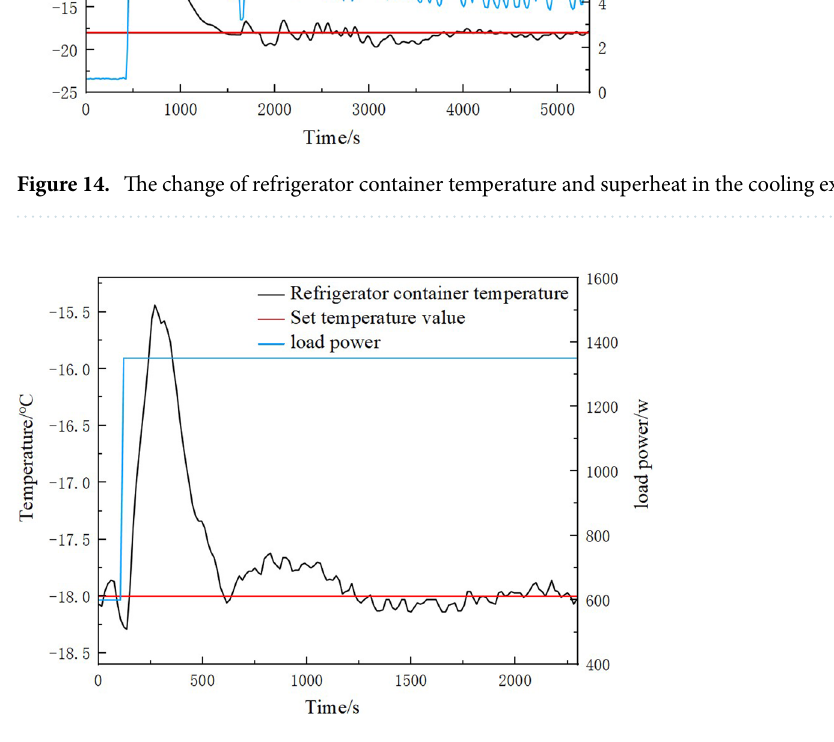
Figure 15. The temperature change process of the refrigeration container in the 750 W load step